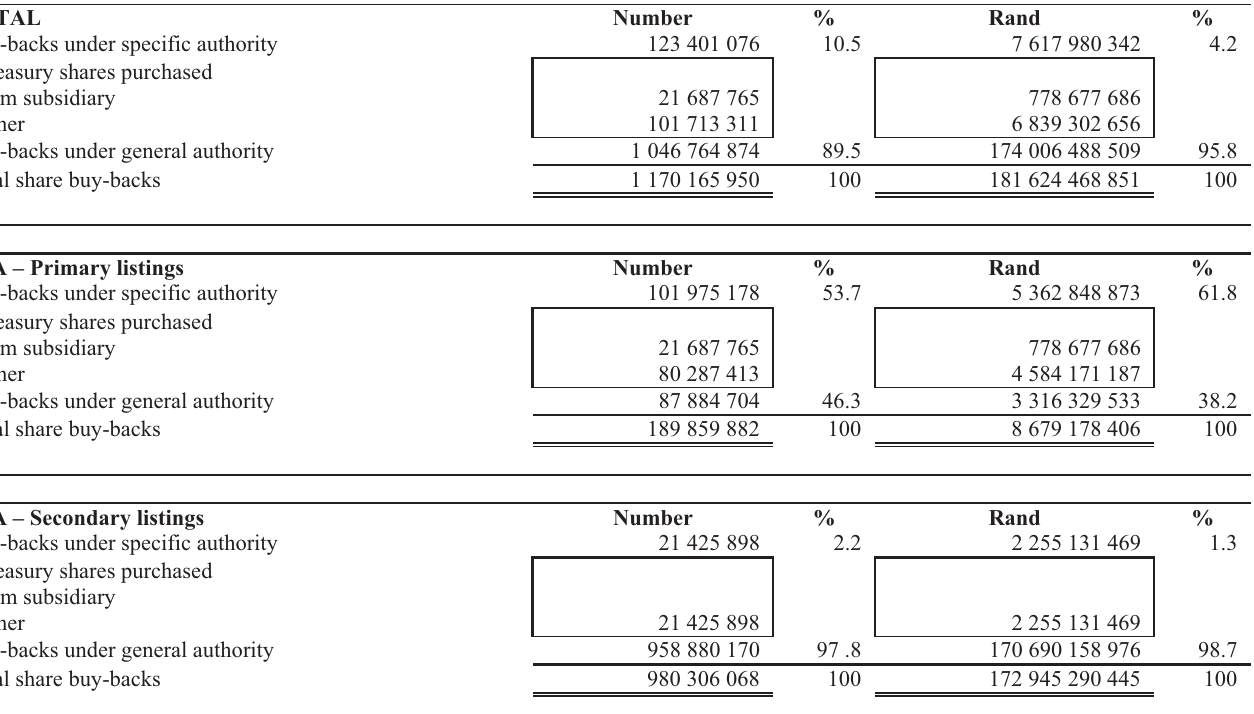
Table 3: Share buy backs: Specific versus general authority